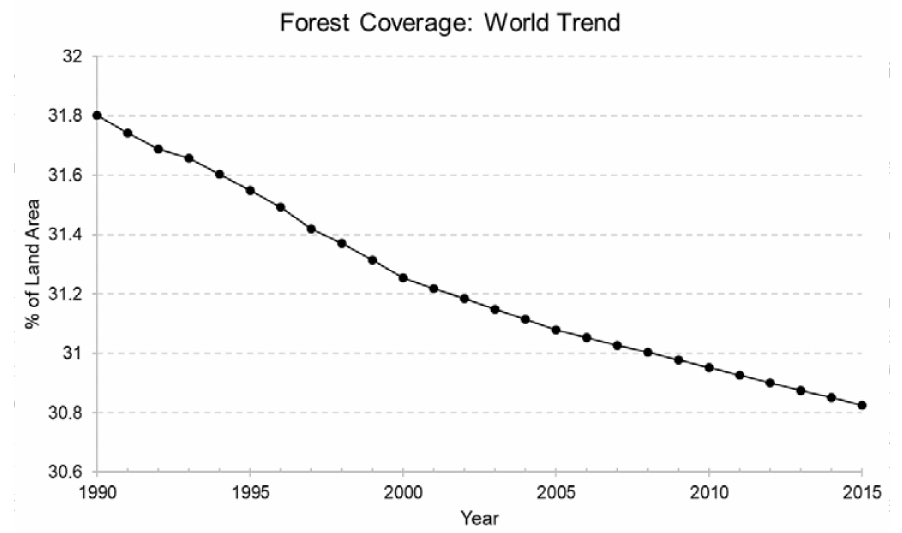
Figure 3. Forest coverage (% of land area). Data source: World Bank